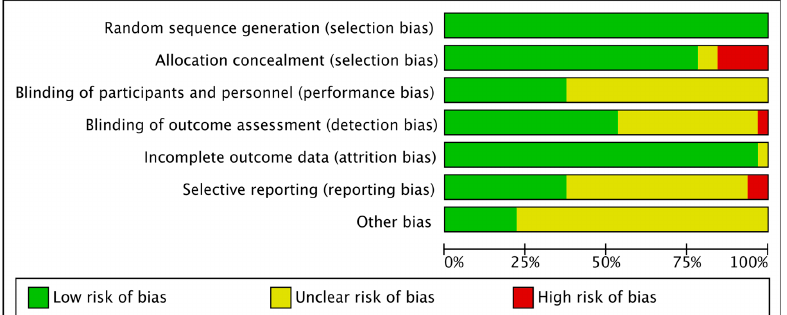
Int. J. Environ. Res. Public Health 2022 , 19 , x FOR PEER REVIEW Figure 2. Overall summary of risk of bias in the included studies. Figure 2. Overall summary of risk of bias in the included studies.